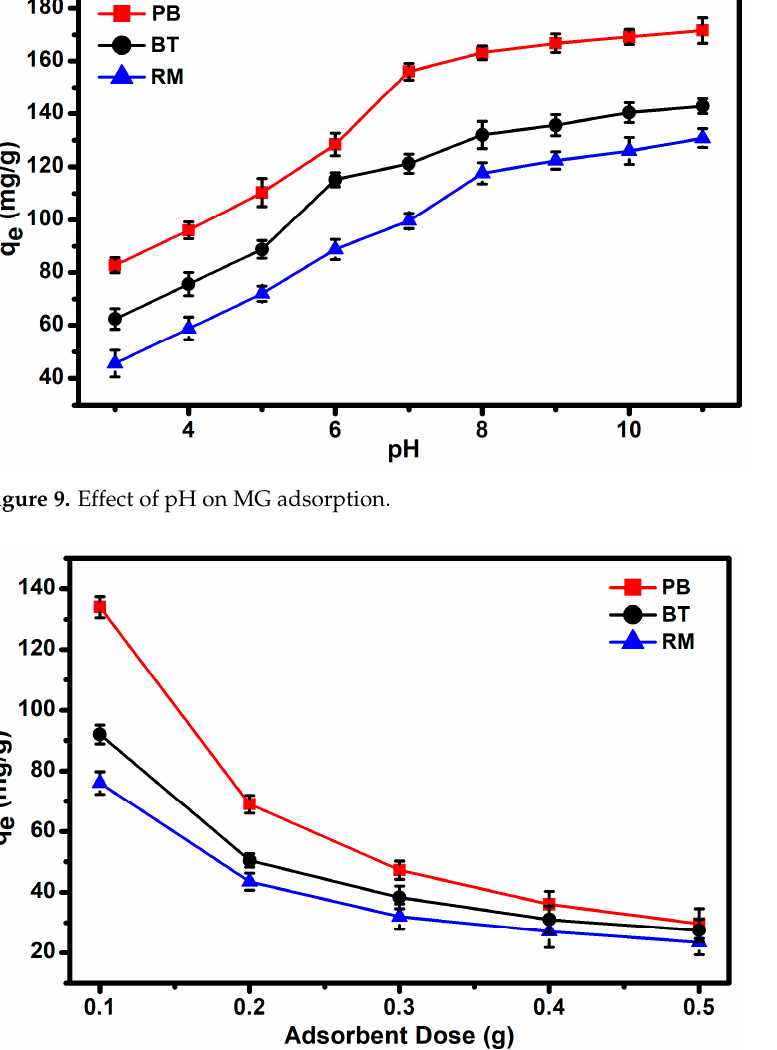
Figure 10. Effect of adsorbent dose on MG adsorption.